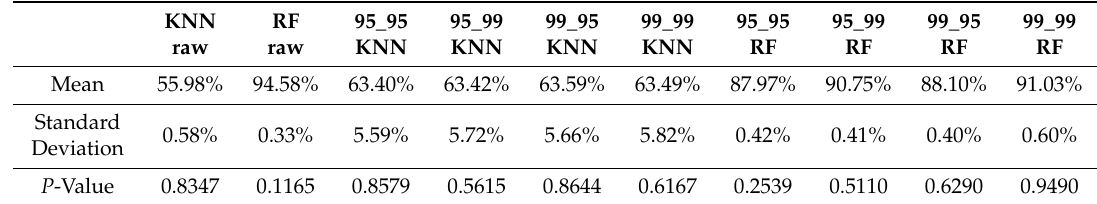
Table 14. Mean, standard deviation, and p -value for Anderson Darling test, for the RF and KNN models tested against raw sets.